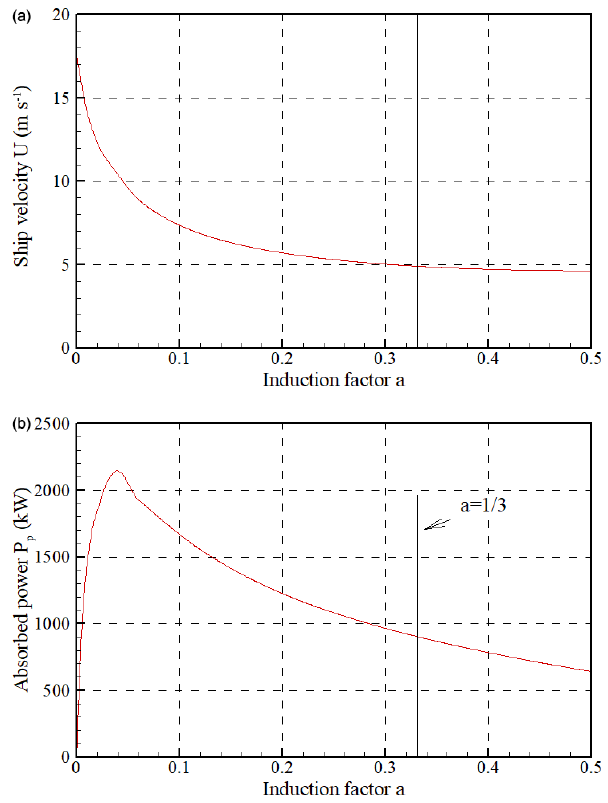
Figure 5. Ship velocity (a) and absorbed power (b) as function of the induction factor. The true wind speed is 10ms − 1 and the true wind angle is 90 ◦ . The wind propulsion subsystems are Flettner rotors. The spin ratio is 3. Constraints on maximum rotational ve- locity, maximal thrust and cut-out speed are not taken into account in this example.